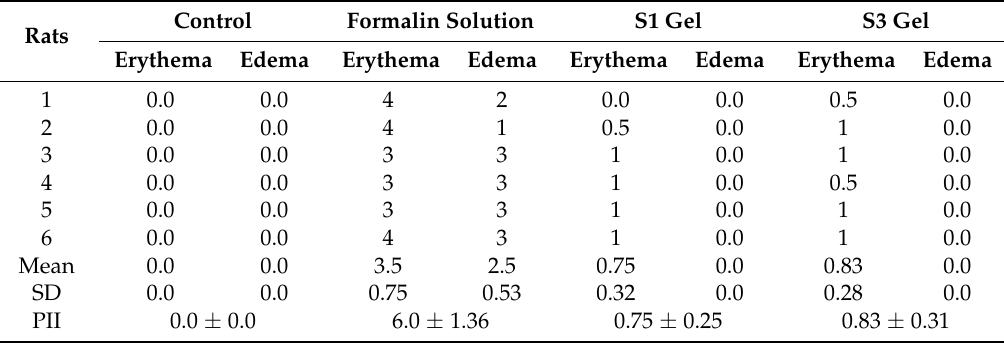
Table 4. Skin irritancy test, Visual observation values were expressed as Mean ± SD, n = 6; S1 proniosomal gel; S3 proniosomal gel; Control = untreated rats. Erythema scale: 0, none; 1, slight; 2, well defined; 3, moderate; and 4, scar formation. Edema scale: 0, none; 1, slight; 2, well defined; 3, moderate; and 4, severe.